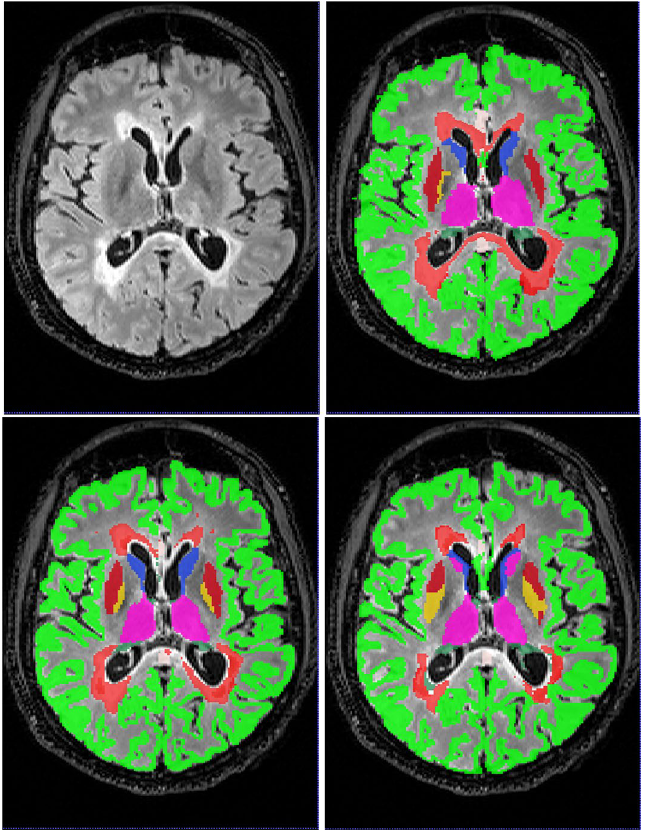
Figure 4. An axial slice of case 1016SACH from the MSSEG dataset. Top left, FLAIR, top right, fused ’ground truth’, bottom left, DeepSCAN segmentation, trained on the Insel90 dataset, bottom right, nnUnet segmentation, trained on the same Insel90 dataset. nnUnet model incorrectly labels parts of Caudate nucleus as Thalamus, and incorrectly places boundary between Pallidum and